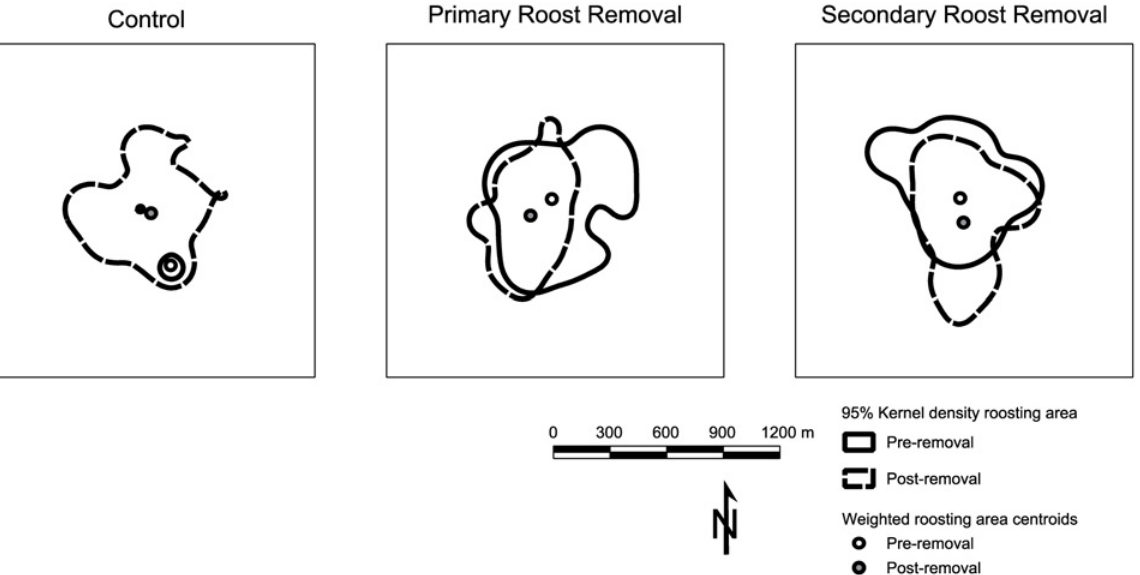
Figure 1. Northern long-eared bat maternity colony roosting areas. Roosting areas (95% utilization distribution) of 3 northern long-eared bat ( Myotis septentrionalis ) maternity colonies subjected to different levels of roost removal on the Fort Knox military reservation, Kentucky, USA, pre- and post- roost removal (2011 and 2012)